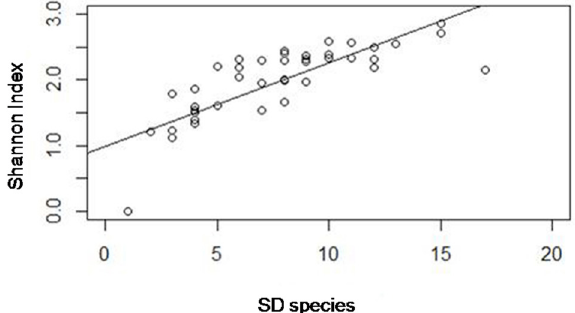
Figure 3. Relation of singleton and doubleton species (SD species) with the Shannon diversity